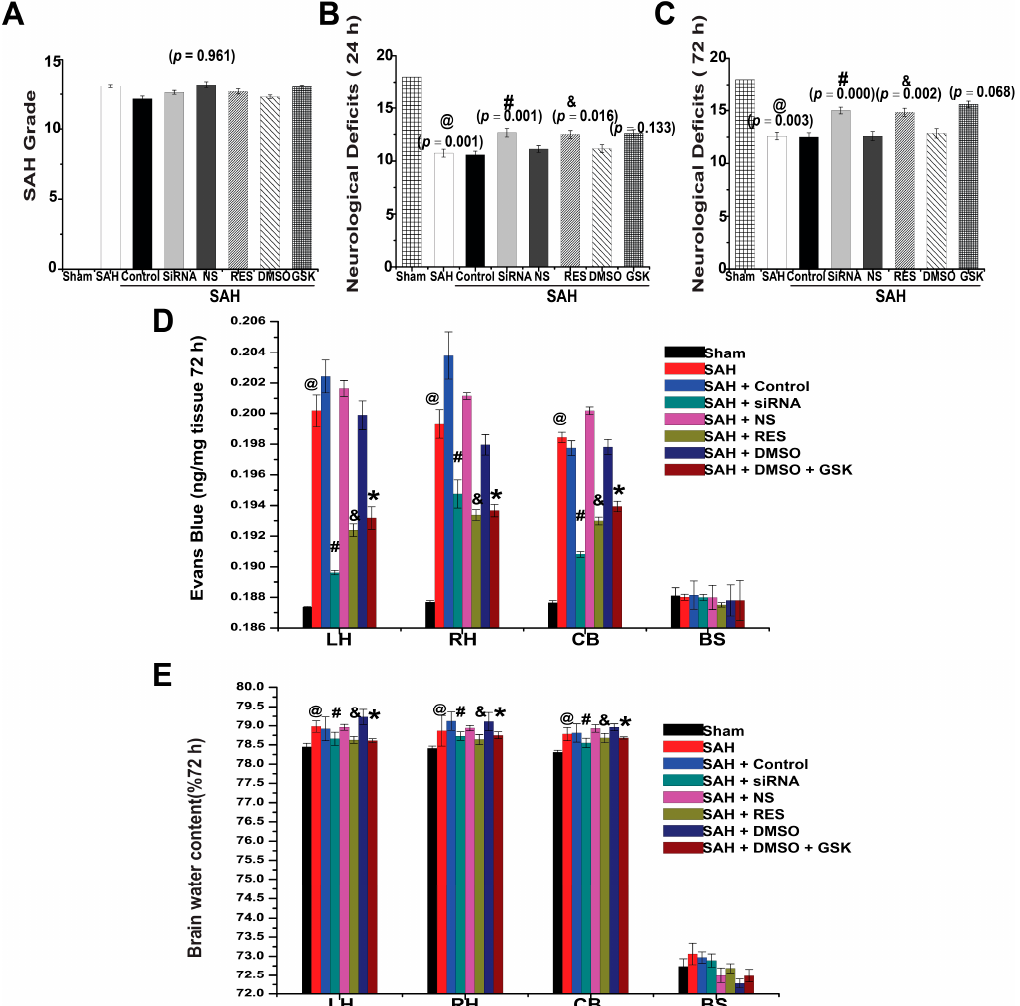
Figure 7. The SAH grade, neurological deficits, blood-brain barrier (BBB) permeability, and brain water content. ( A ) SAH grading scores were similar among each surgery group; ( B , C ) TXNIP siRNA and RES increased the neurological score, but GSK2656157 treatment did not result in significant improvement in the neurological deficits compared with the control group; ( D ) BBB disruption was also attenuated in three sections after TXNIP siRNA, RES, and GSK2656157 treatment; ( E and Table S1) The brain water content was reduced by TXNIP siRNA, RES, and GSK2656157 treatment. @ p < 0.05 vs. Sham; # p < 0.05 vs. SAH + control siRNA, & p < 0.05 vs. SAH + NS, * p < 0.05 vs. SAH +